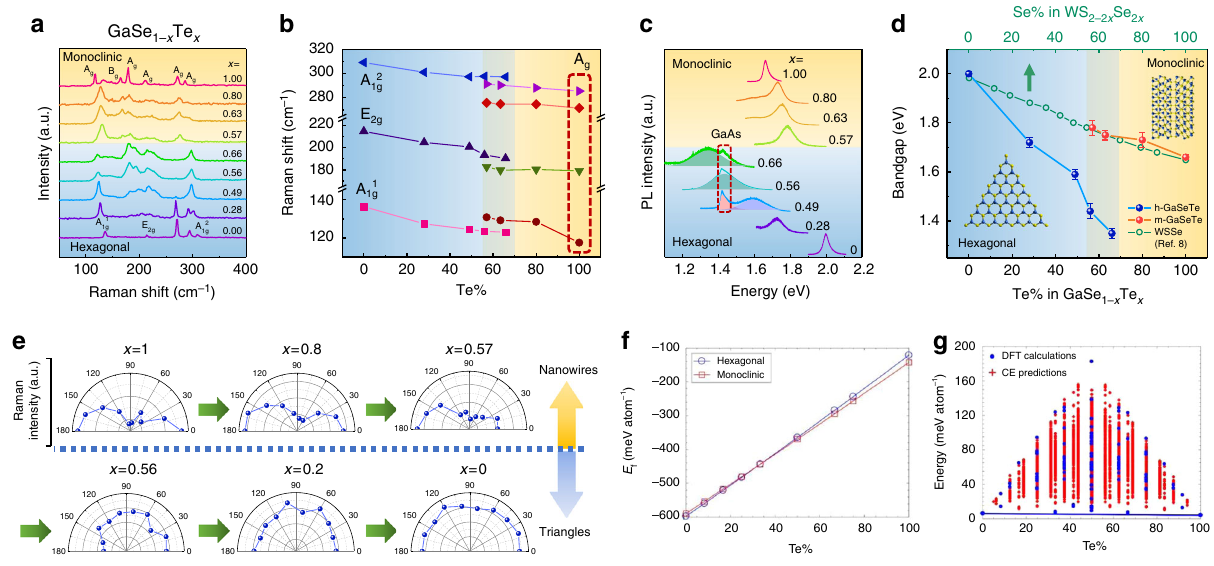
Fig. 2 Vibrational properties and bandgap as a function of composition. a Raman spectra of GaSe 1 − x Te x nanostructures at different compositions. Monoclinic and hexagonal structures are separated by different background colors. b Peak positions of different Raman modes as a function of Te content in GaSe 1 − x Te x . Blue background indicates the hexagonal side and yellow background indicates the monoclinic side. c PL spectra of GaSe 1 − x Te x nanostructures at different compositions. d Bandgap as a function of Te content in GaSe 1 − x Te x . Error bars indicate standard deviation of PL peak position measured from fi ve or more points on the same sample. e Evolution of angle resolved Raman peak intensity as Te content decreases. f , g DFT cluster expansion calculations at a variety of elemental composition shows that there exists a crossover region in formation energies of hexagonal to